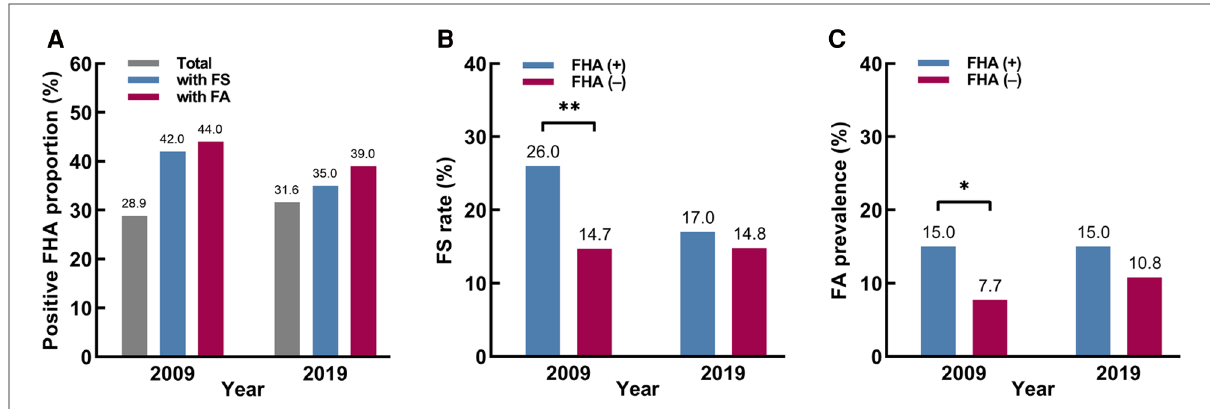
FIGURE 2 The proportions with a positive family history of atopic diseases (FHA), food sensitization (FS) rates and food allergy (FA) prevalence among different participants. ( A ) The positive FHA proportions among different participants. ( B ) The FS rates based on FHA. ( C ) The FA prevalence based on FHA. * P <0.05. ** P <0.01.